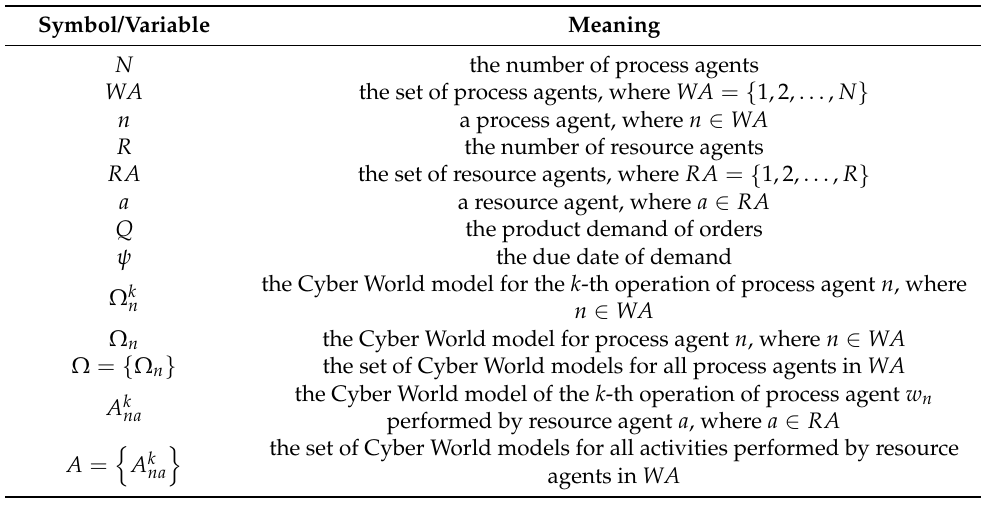
Table 1. Notations used in problem